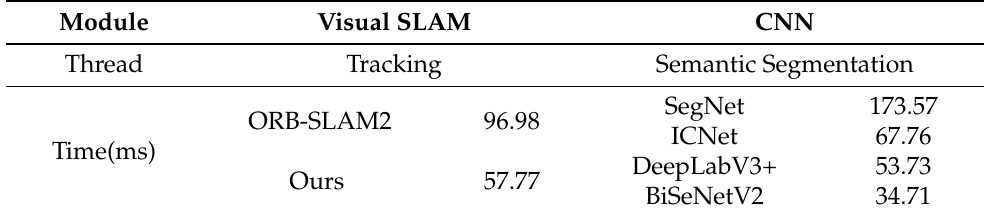
Table 4. Runtime test results (ms) per frame on the UAV